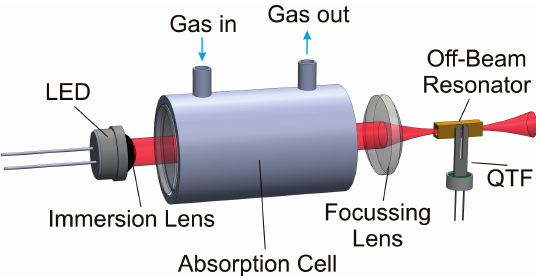
Figure 1. Sketch of the experimental setup for absorption-QEPAS. The detector cell